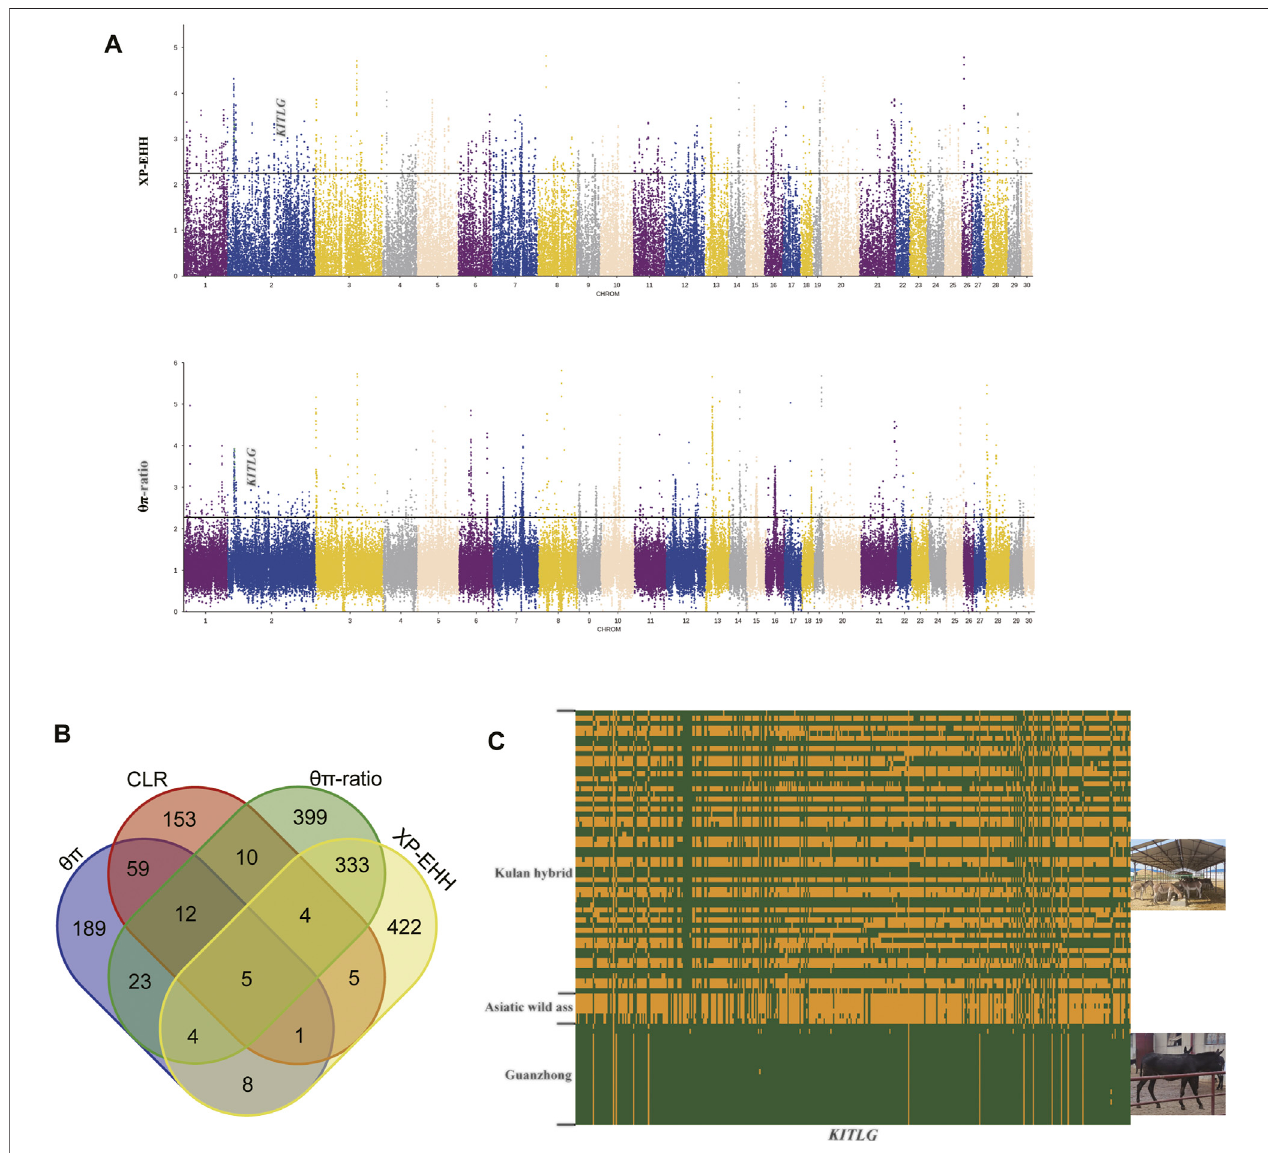
FIGURE3| Analysisofthesignaturesofpositiveselectioninthegenome. (A) Manhattanplotofselectivesweeps. (B) Venndiagramshowingthegenesoverlapping among θπ , CLR, θπ -ratio and XP-EHH. (C) Linkage disequilibrium analysis of the SNPs in KITLG regions.